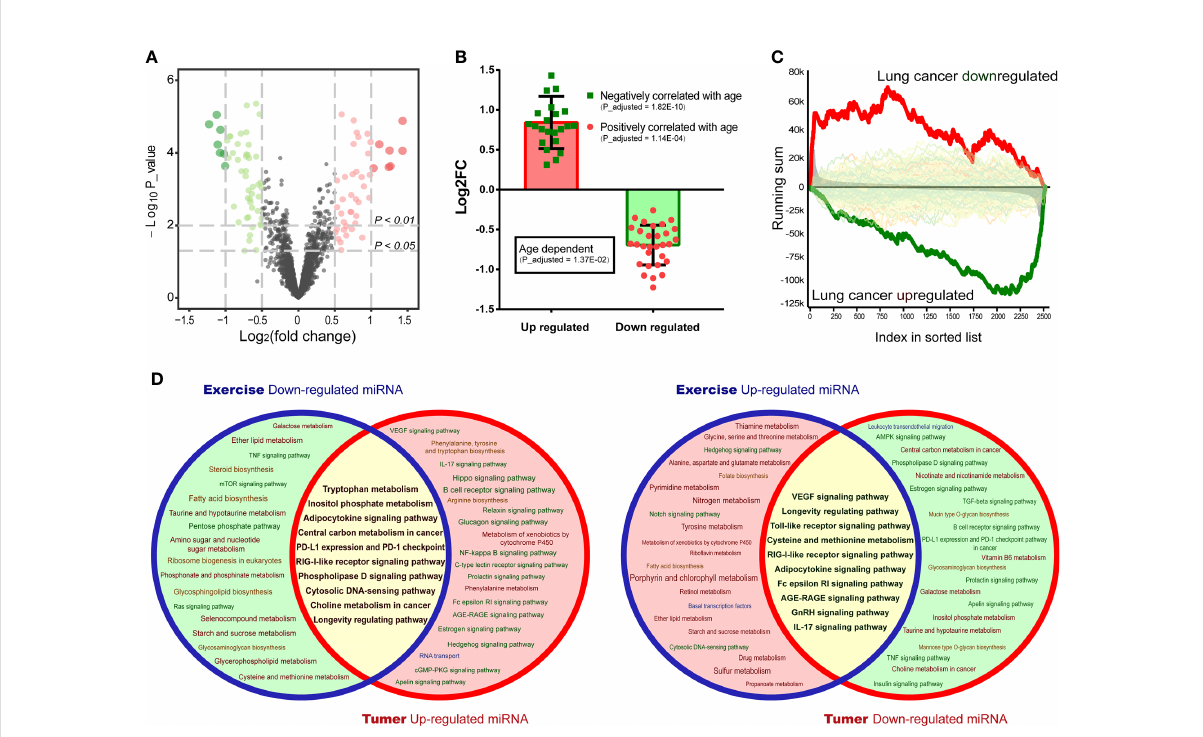
FIGURE 3 Interaction analysis of exercise/LC-associated miRNAs. (A) Volcano plots draw the regulated circulating miRNAs in plasma after exercise in a dataset of GSE133910. (B) Age-dependent genes were annotated by miEAA, and each knot represents an age-related differentially expressed miRNA ( p < 0.01) in the exercise dataset. (C) The circulating miRNAs were ranked by the value of log2FC, and disease correlation analysis was performed by GSEA. The enriched(red) or depleted(green) subcategory was shown based on the running sum. (D) Pathway prediction analysis of exercise-regulated miRNAs ( p < 0.01) and screened LC miRNAs was performed by miEAA. The overlapping regions (yellow) represent the co- intervention